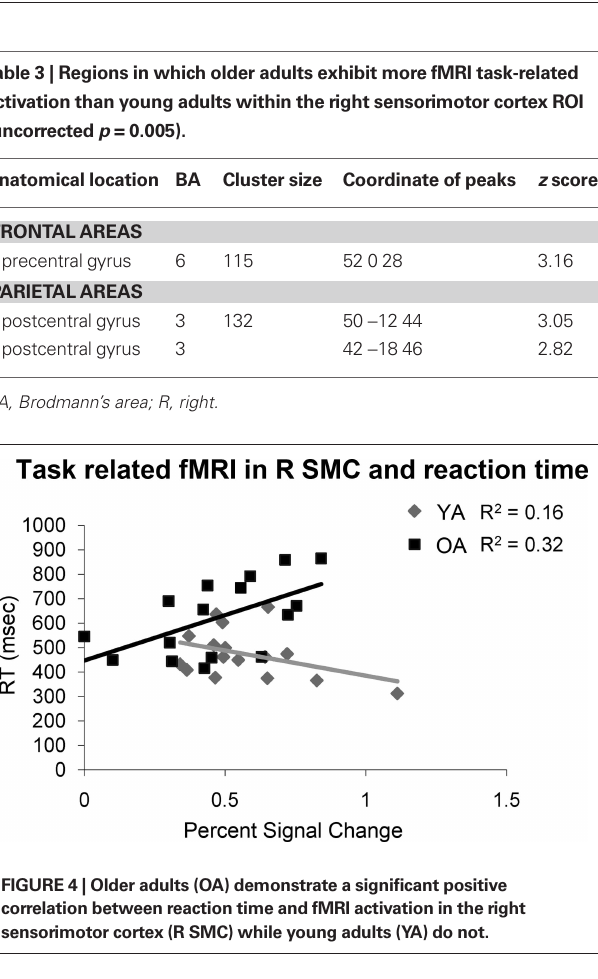
FIguRe 3 | Regions within the sensorimtor cortex ROI in which the older adults exhibited more motor task related activation (fMRI) than the young adults.